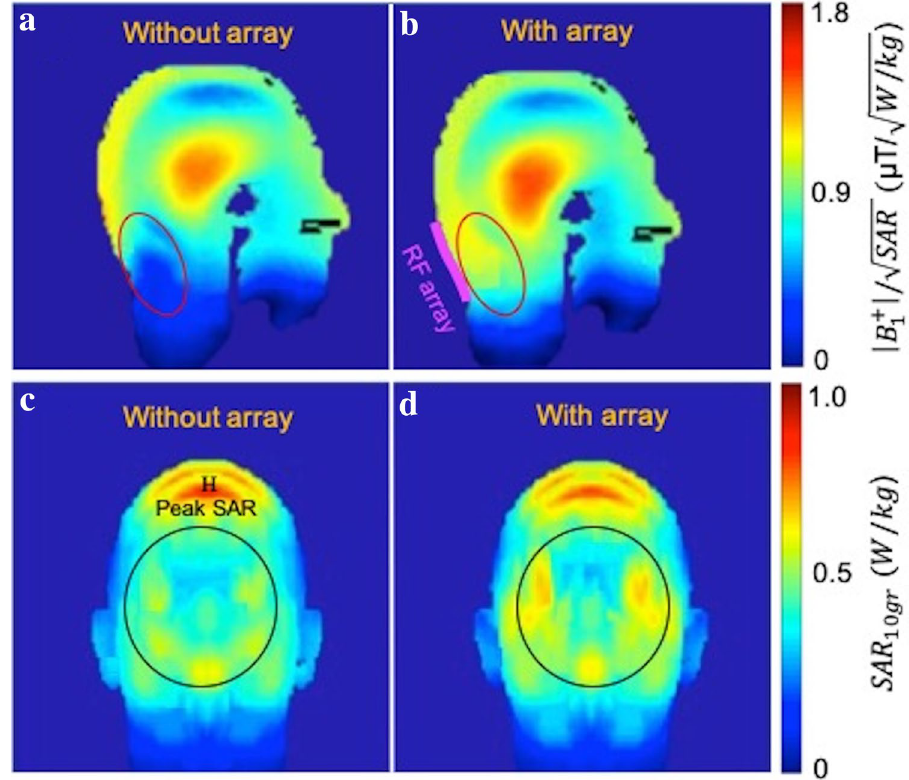
Figure 3. Simulated transmit field efficiency of a birdcage head coil ( a ) without the array and ( b ) in the presence of the array. Using the array resulted in improved transmit efficiency by factor of 3 in caudal regions of the brain when compared with the cases with no array. Simulated 10 gr local SAR distribution of the head coil without the array ( c ) and in the presence of the array ( d ). In the presence of the array the local SAR increased 24% at the area covered by the array indicated by a circle; and the peak SAR decreased %9 in the presence of the array.